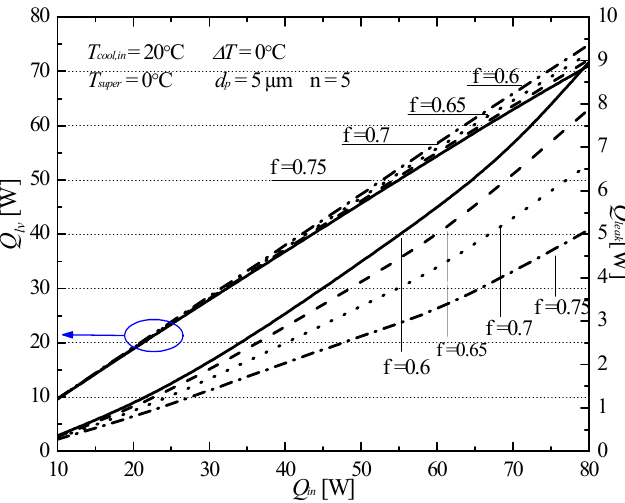
Figure 10. Variations in Q lv and Q leak with input thermal load for different porosities.